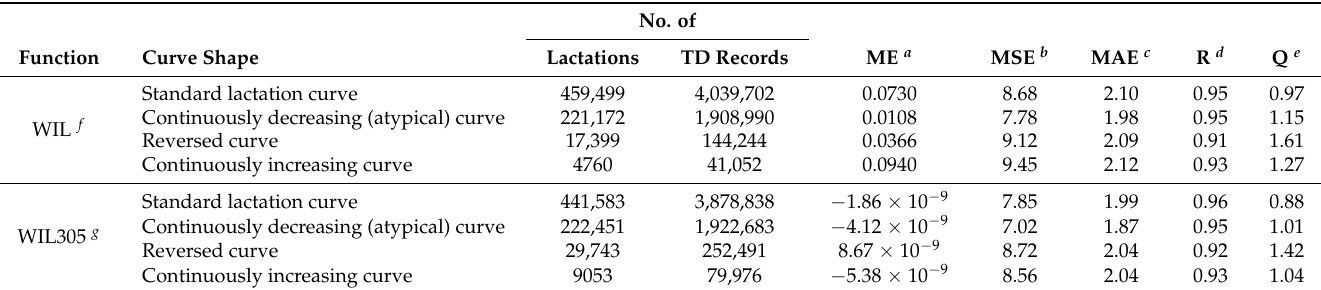
Figure 2. Examples of different first lactation curve shapes fitted using Wilmink (WIL305) function. Table 4. Goodness of fit of WIL and WIL305 functions to test-day (TD) milk yields until 305 day in milk, by different shape of lactation